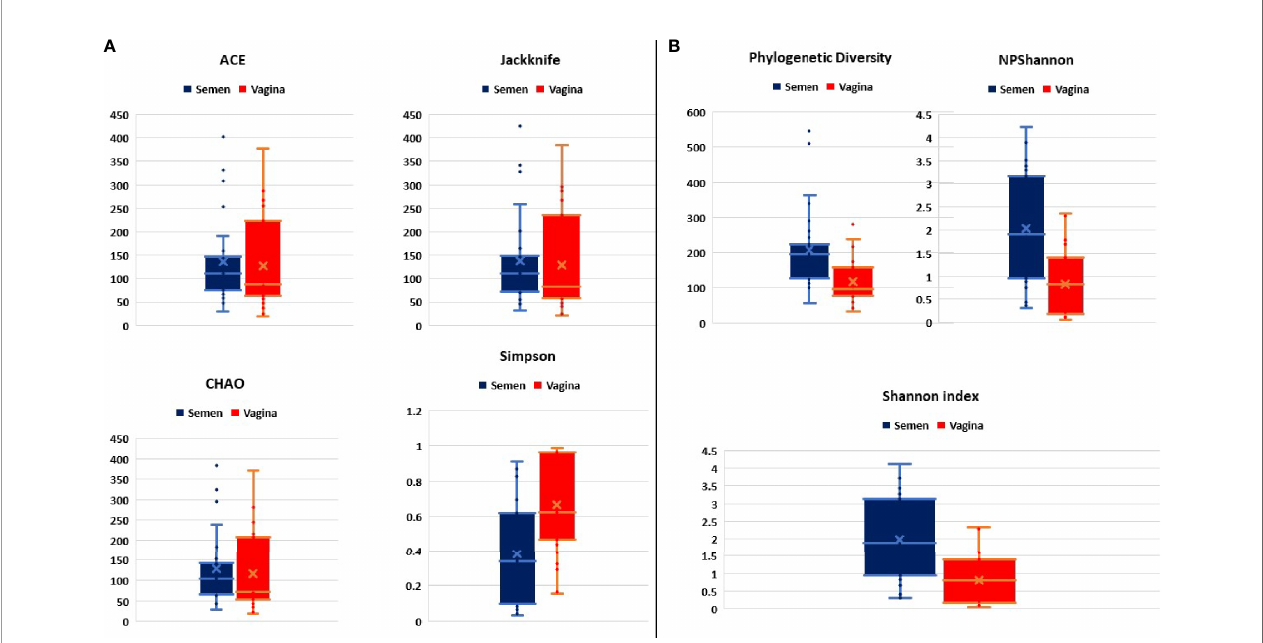
FIGURE 1 | (A, B) Comparative alpha diversities between semen and vagina showing species richness typi fi ed by ACE, CHAO Jackknife, Shannon, and Simpson